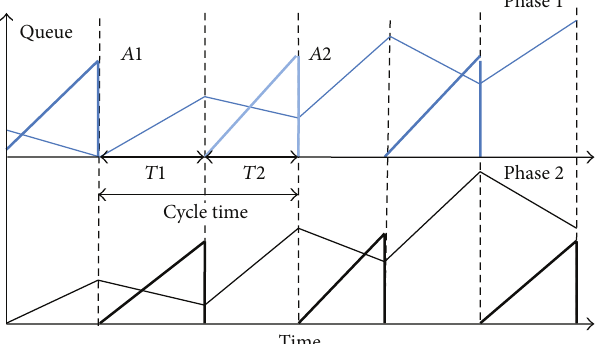
Figure 3: Sensitivity analysis for two-phase intersection.